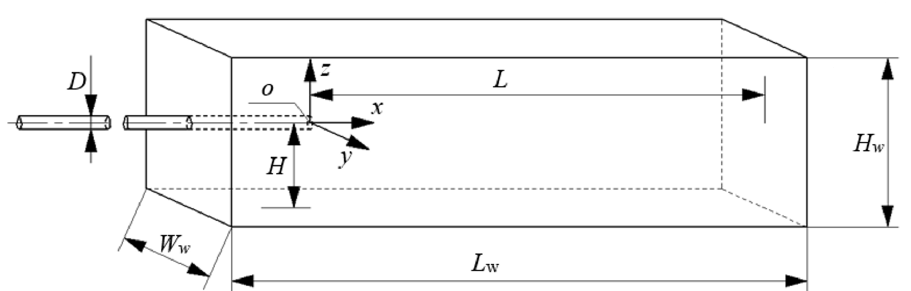
Table 1. Detailed dimensions of the computational model.